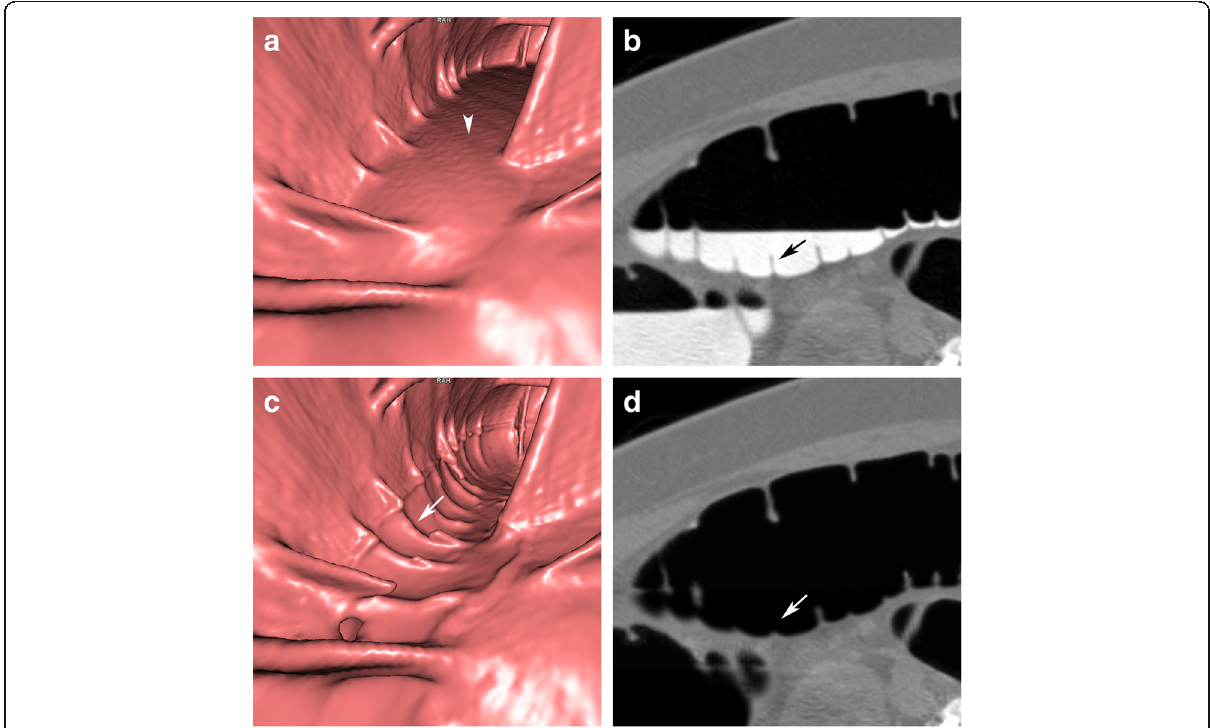
Fig. 8 Pseudodefects of haustral folds, submerged under tagged residual fluid after EC. a On endoluminal 3D views, a horizontal fluid layer is found in the transverse colon, obscuring parts of the colonic wall before EC (arrowhead). Only those parts of the colon wall and haustral folds that lie above the fluid layer are visible. b On sagittal 2D views, thin haustral folds are submerged under tagged residual fluid (arrow). c , d After EC, the residual fluid is removed. Note that the submerged parts of haustral folds show defects, disappearing entirely (arrow), while those parts of the haustral folds that are not submerged do not change in appearance on ( c ) endoluminal 3D views and ( d ) sagittal 2D